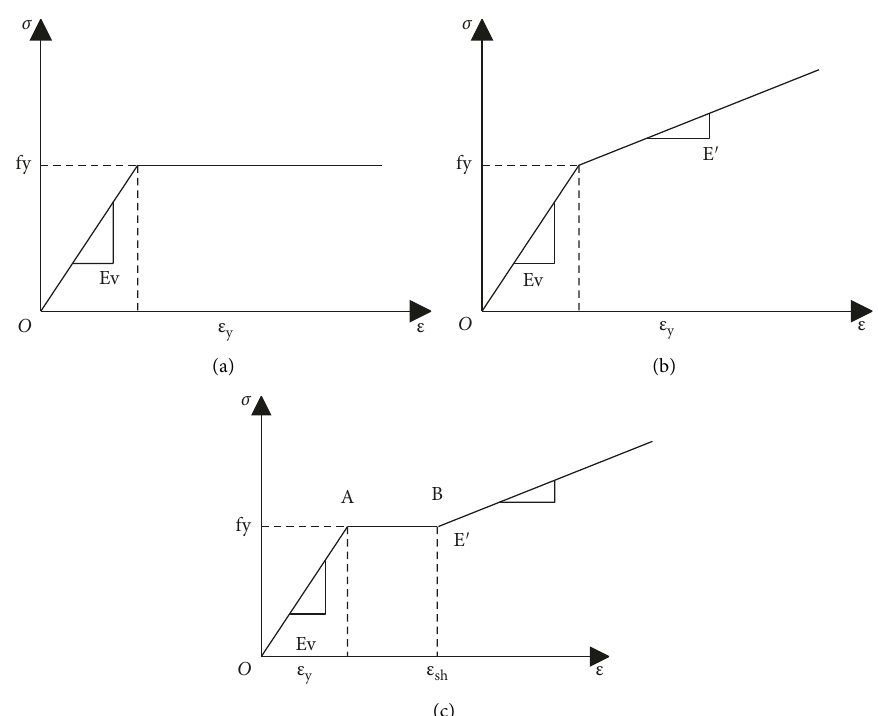
Figure 2: Reinforcing constitutive model. (a) Double straight line model. (b) Linear reinforced plasticity model. (c) Trilinear